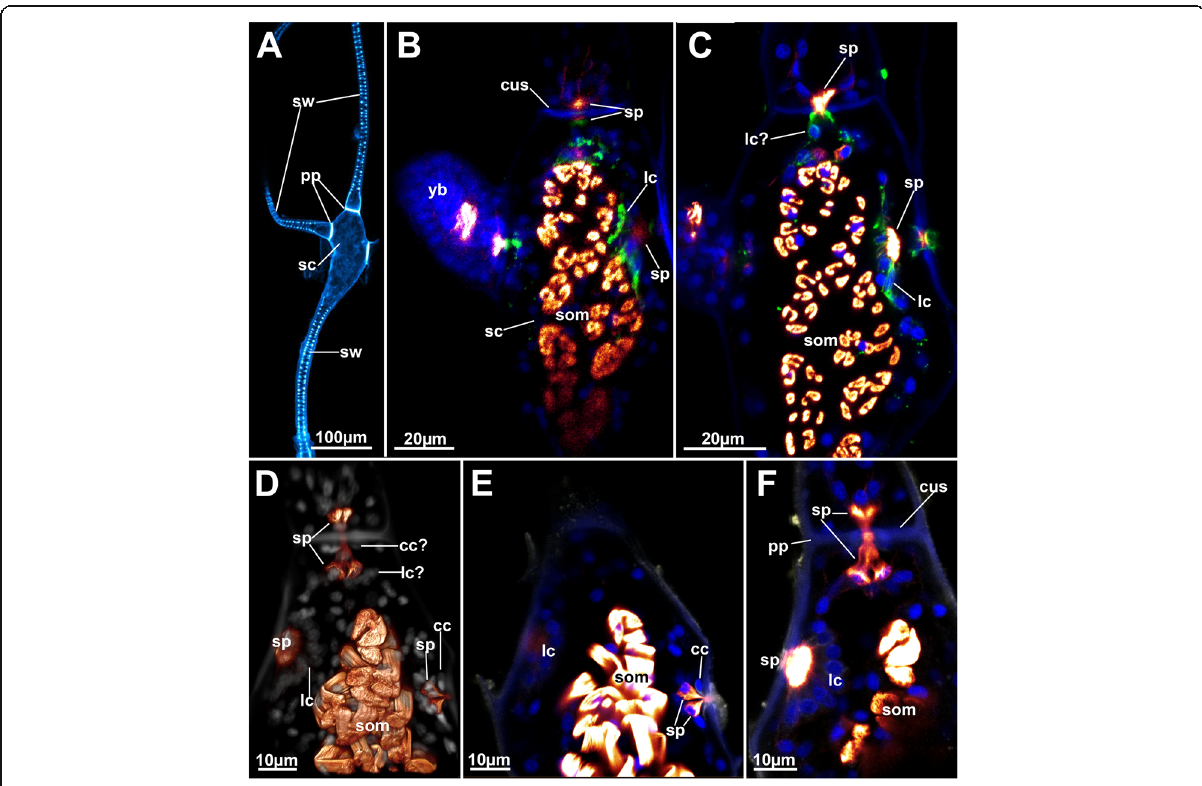
Fig. 2 Stolonal structure of Hypophorella expansa . CLSM. a Overview using autofluorescence of a stolon. The proximal part of the stolon (lower side of the image) is thin and contains cuticular wrinkles. The distal part is widened to a capsule that also bears connections to adjacent zooids. b & c Optical sections of a stolon capsule in different planes. Staining for f-actin (glow), nuclei (blue) and acetylated alpha tubulin (green). d Volume rendering of a stolon capsule showing autofluorescence (grey) and f-actin (glow). e & f Optical sections of the same data set as shown in ( d ) in different section planes. Abbreviations: cc – cincture cell, cus – cuticular septum, lc – limiting cells, pp. – pore plates, sc – stolon capsule, som – stolonal transverse muscle, sp. – special cell, st – stolons, sw – stolonal wrinkles, yb – young